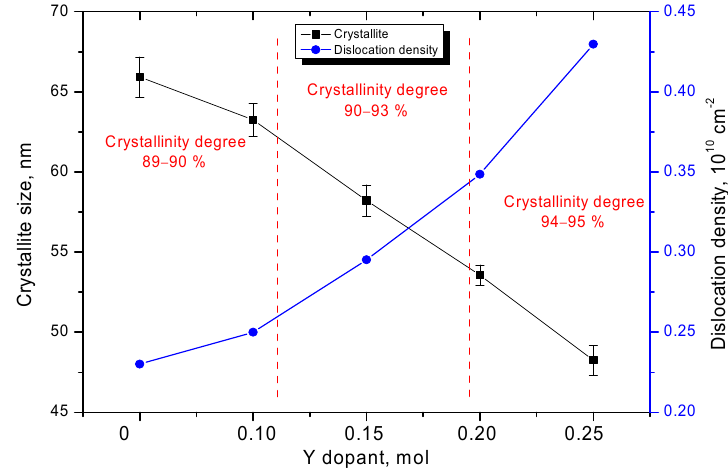
Figure 5. Results of changes in the crystallite sizes and dislocation density.